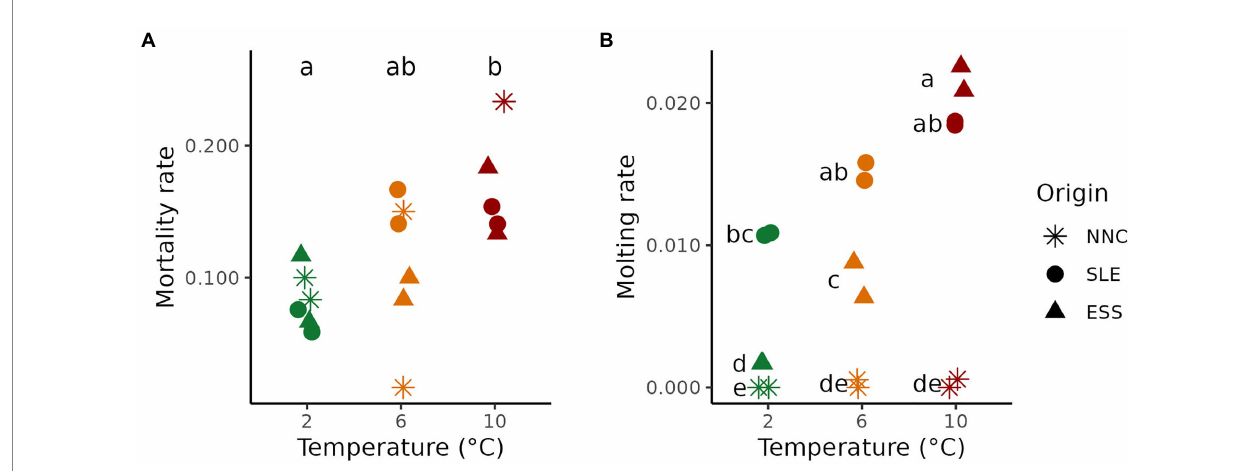
FIGURE 2 Pandalus borealis mortality and molting rates as function of Temperature and Origin. (A) Mortality rate at each treatment temperature (green, orange and red for 2, 6 and 10 ° C, respectively) for shrimp from different origins (shape). (B) Molting rate at each treatment temperature for shrimp from different origins. The results of Tukey HSD post hoc test are displayed as letters, with different letters representing a significant difference between means ( p < 0.05). ESS = Eastern Scotian Shelf, SLE = St. Lawrence Estuary, NNC = Northeast Newfoundland Coast. Both replicate tanks for each treatment are